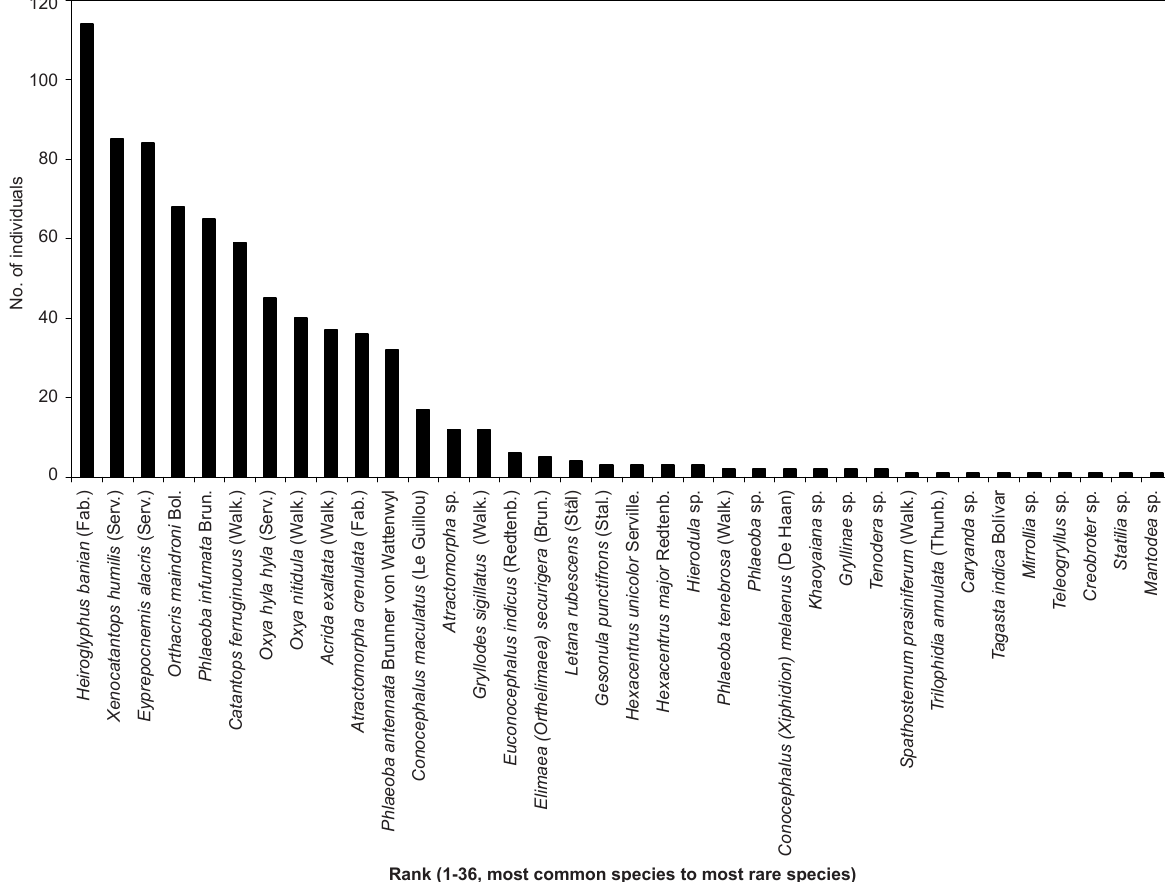
indices H’, and λ appear useful as they incorporate both species richness and evenness into a single value. Shannon’s (H’) diversity index appears to have more value (2.28 to 2.4) (Table 2). The present study indicates that orthopteran species are more diverse in KNP. Distribution